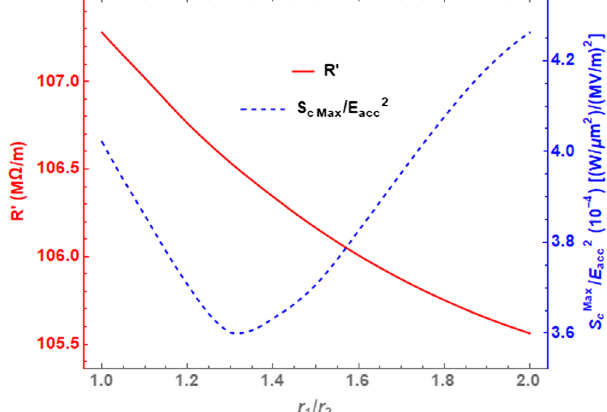
FIG. 3. The shunt impedance per unit length R 0 and the normalized modified Poynting vector S the elliptical iris radii ratio r 1 =r 2 for iris radius a ¼ 3 . 2 mm.